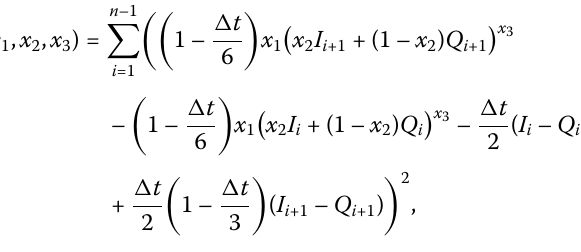
the parameter estimation problem of the nonlinear Muskingum model. The Muskingum model has the following